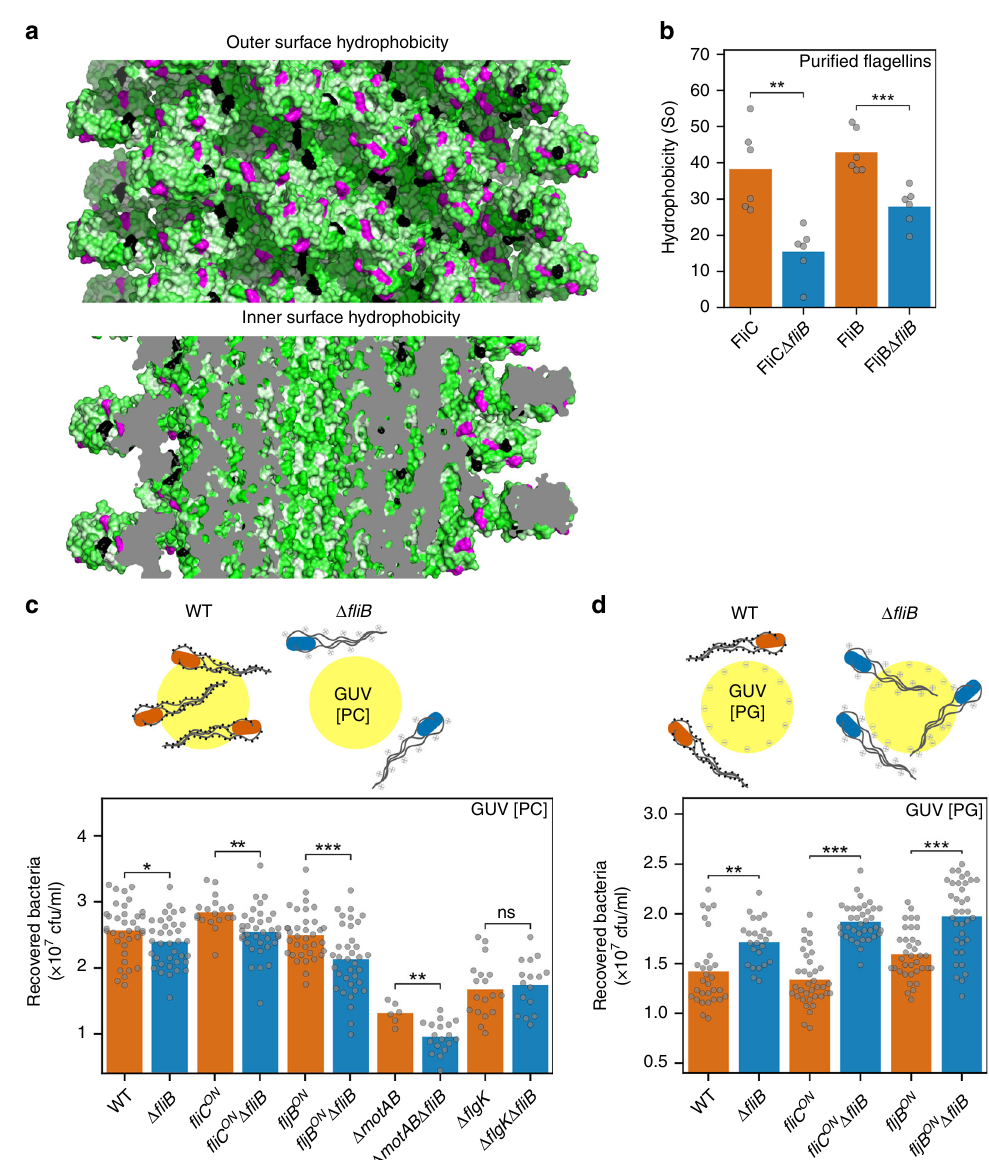
Fig. 5 Flagella methylation mediates adhesion to hydrophobic surfaces. a Methylation increases hydrophobicity of the fl agellar fi lament outer surface. Surface hydrophobicity distribution of the outer (top) and inner (bottom) surface of the FliC fl agellar fi lament 70 according to the Eisenberg scale 71 (from green to white indicates increasing hydrophobicity) with methylation sites highlighted in magenta and non-methylated lysines in black. b Measured surface hydrophobicity (So) of methylated and non-methylated ( Δ fl iB ) fl agellins using PRODAN on puri fi ed fl agellar fi laments. n = 6 independent experiments. Replicates are shown as individual data points and statistical signi fi cances were determined by a two-tailed Student ’ s t test (** = p < 0.01; *** = p < 0.001. FliC vs. FliC Δ fl iB : p = 0.0020, FljB vs. FljB Δ fl iB : p = 0.0009). c Adhesion of Salmonella Typhimurium to giant unilamellar vesicles (GUV) consisting of phosphatidylcholine (PC) from egg chicken is facilitated by the presence of methylated fl agella. Top: schematic illustration of the adhesion of Salmonella to PC-GUVs, which is facilitated by methylated fl agella. Bottom: Quanti fi ed adhesion of Salmonella mutants to PC-GUVs. WT, Δ fl iB, fl jB ON Δ fl iB, fl iC ON Δ fl iB : n = 36 ; fl jB ON : n = 35; fl iC ON , Δ motAB Δ fl iB, Δ fl gK : n = 18; Δ fl gK Δ fl iB : n = 16; Δ motAB : n = 6 biologically independent samples. Replicates are shown as individual data points and statistical signi fi cances were determined by a two-tailed Student ’ s t test (* = p < 0.05; ** = p < 0.01; *** = p < 0.001; ns = not signi fi cant. WT vs. Δ fl iB : p = 0.0437, fl iC ON vs. fl iC ON Δ fl iB : p = 0.0029, fl jB ON vs. fl jB ON Δ fl iB : p = 0.0009, Δ motAB vs. Δ motAB Δ fl iB : p = 0.025). d Adhesion of Salmonella Typhimurium to GUVs consisting of phosphatidylglycerol (PG) is decreased by the presence of methylated fl agella. Top: schematic illustration of the adhesion of Salmonella mutants to PG-GUVs. Bottom: Quanti fi ed adhesion of Salmonella mutants to PG-GUVs. The bar graphs represent the mean of the reported data. WT: n = 30; Δ fl iB : n = 24; fl iC ON fl iC ON Δ fl iB, fl jB ON and fl jB ON Δ fl iB : n = 36 biologically independent samples. Replicates are shown as individual data points and statistical signi fi cances were determined by a two-tailed Student ’ s t test (** = p < 0.01; *** = p < 0.001. WT vs. Δ fl iB : p = 0.0010, fl iC ON vs. fl iC ON Δ fl iB : p < 0.0001, fl jB ON vs. fl jB ON Δ fl iB : p < 0.0001). The bar graphs represent the mean of the reported data. Source data are provided as a Source Data fi